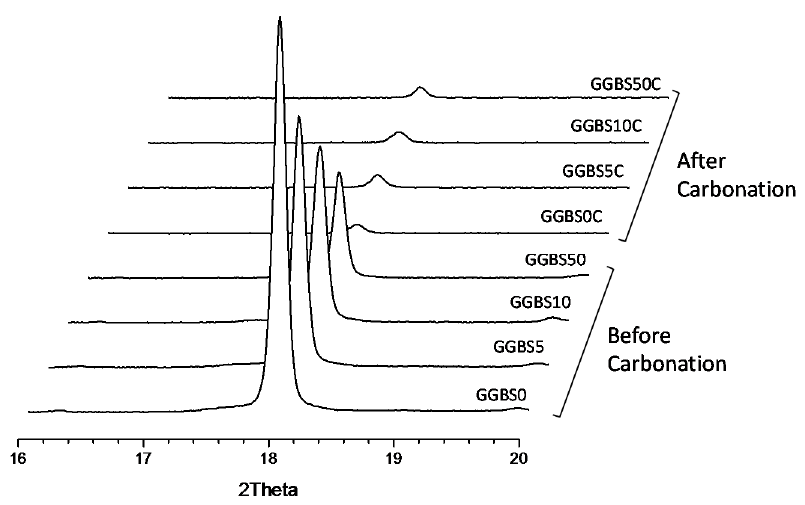
Figure 12. Comparison of the 001 basal reflection from Ca(OH) 2 in GGBS-PC pastes before and after an accelerated carbonation. The numbers followed by GGBS indicate the replacement ratios of GGBS for PC.